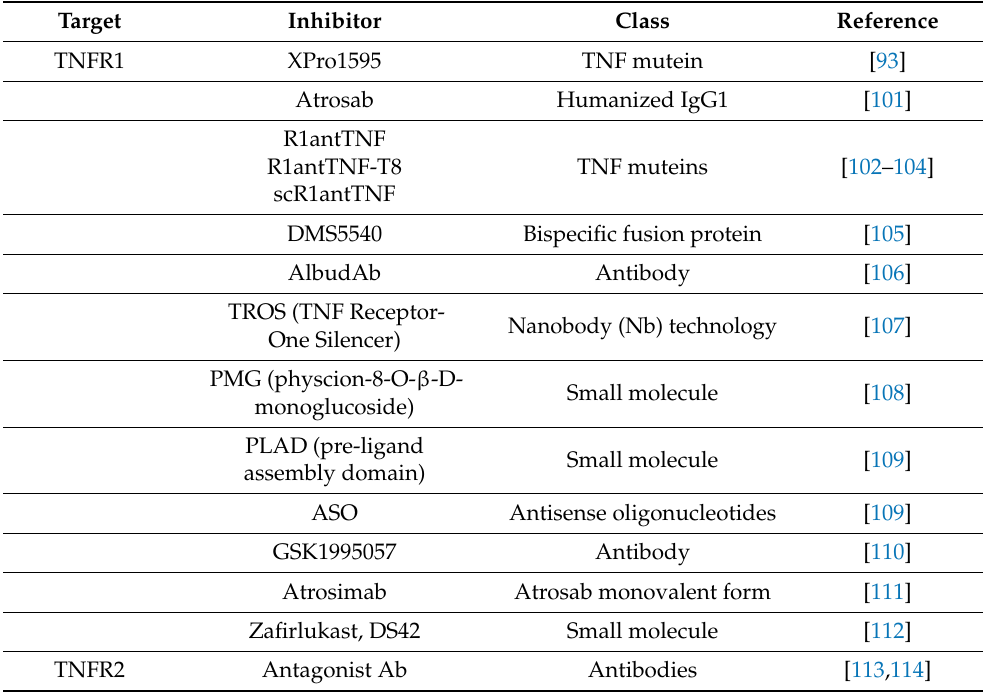
Table 1. Selective TNFR1 and TNFR2 inhibitors under